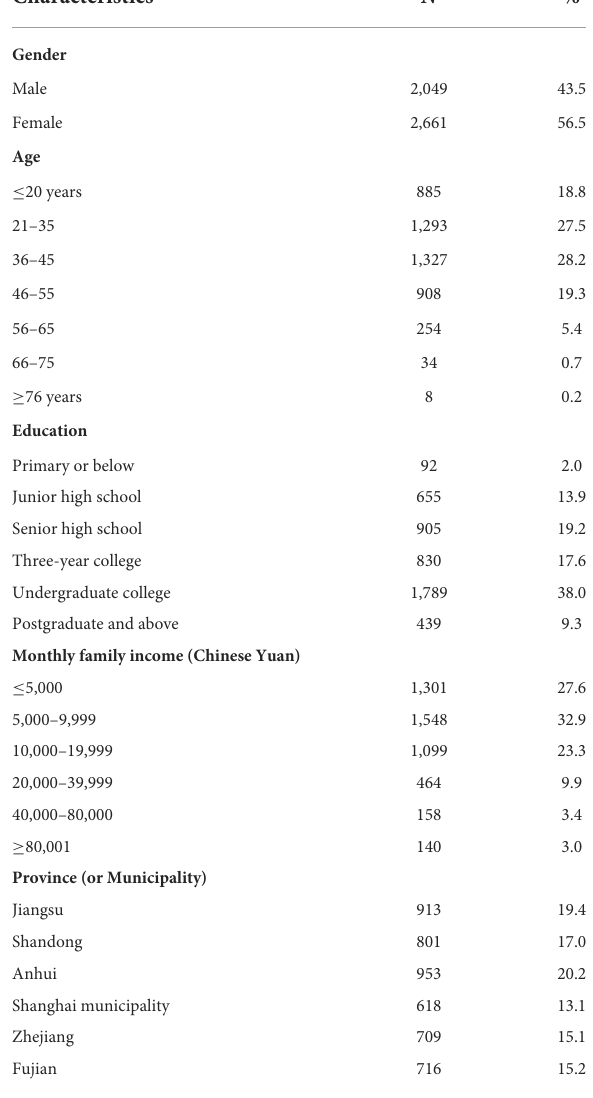
TABLE 1 Respondent characteristics ( N =